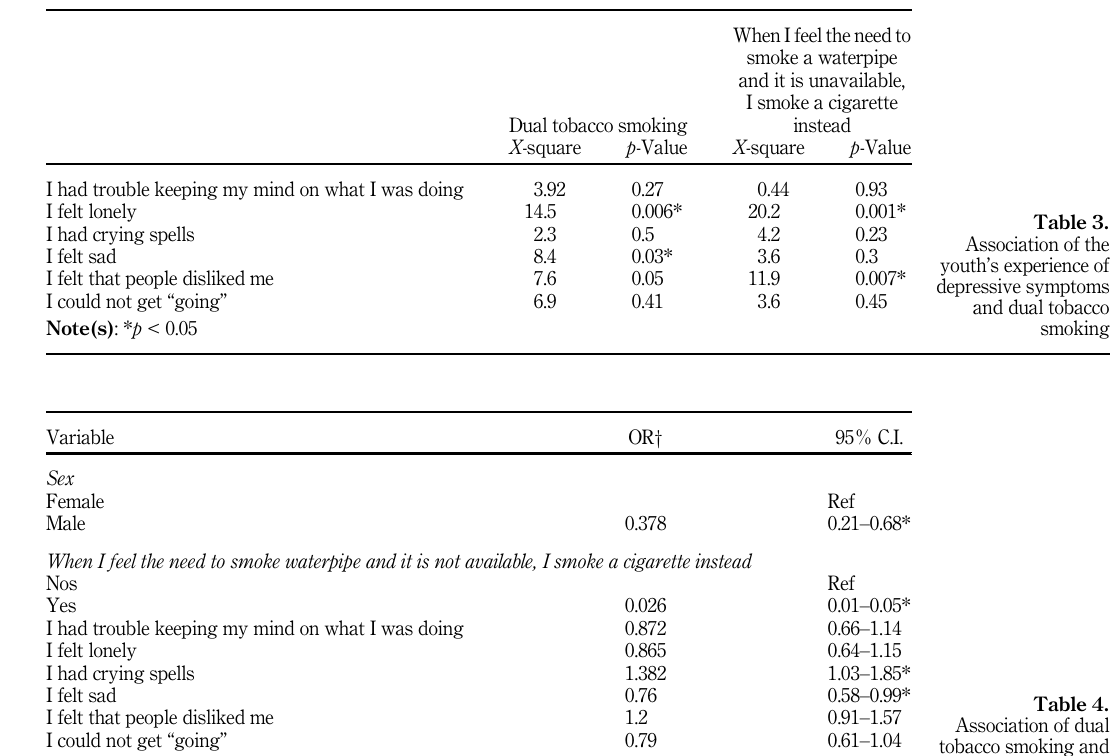
Table 4. Association of